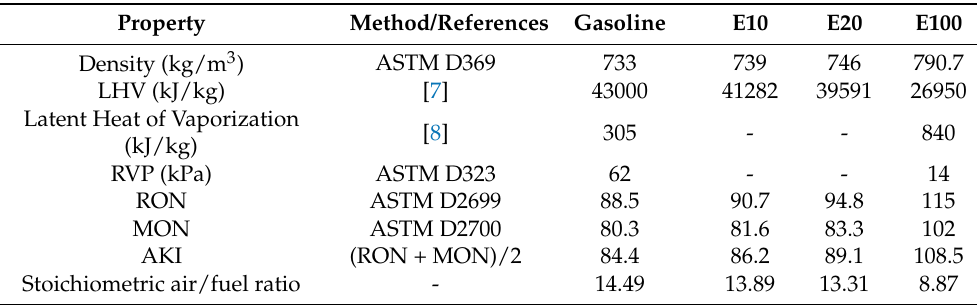
Table 1. Properties of ethanol-gasoline